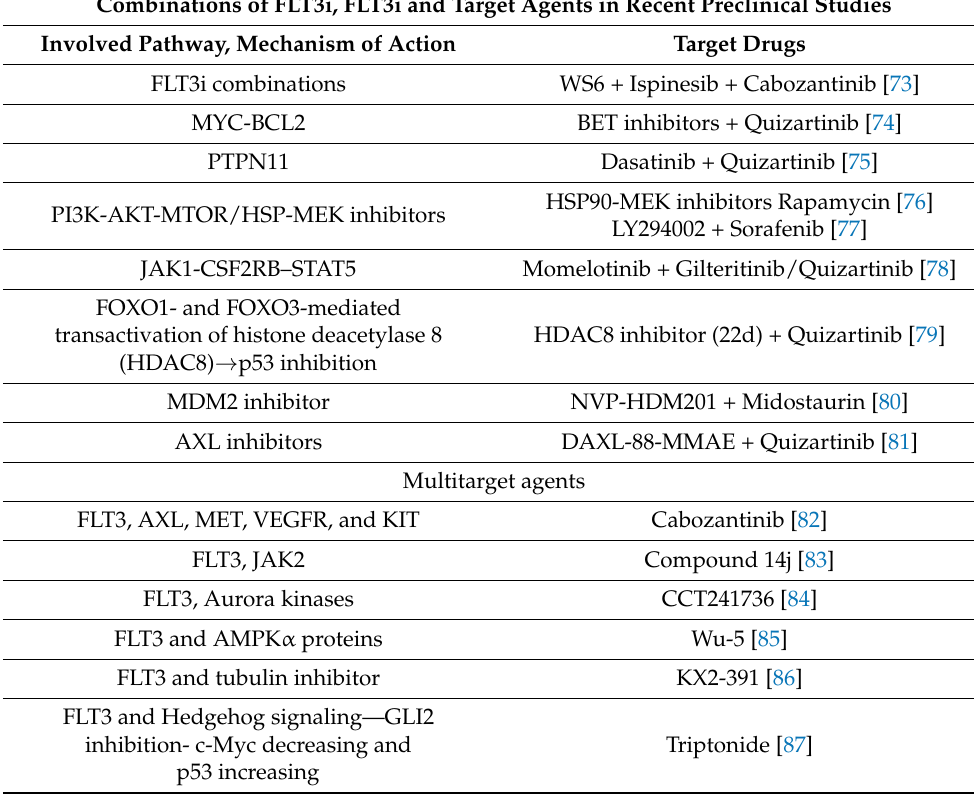
Table 4. Summary of preclinical studies with FLT3i and target agents and their mechanisms of action. Combinations of FLT3i, FLT3i and Target Agents in Recent Preclinical